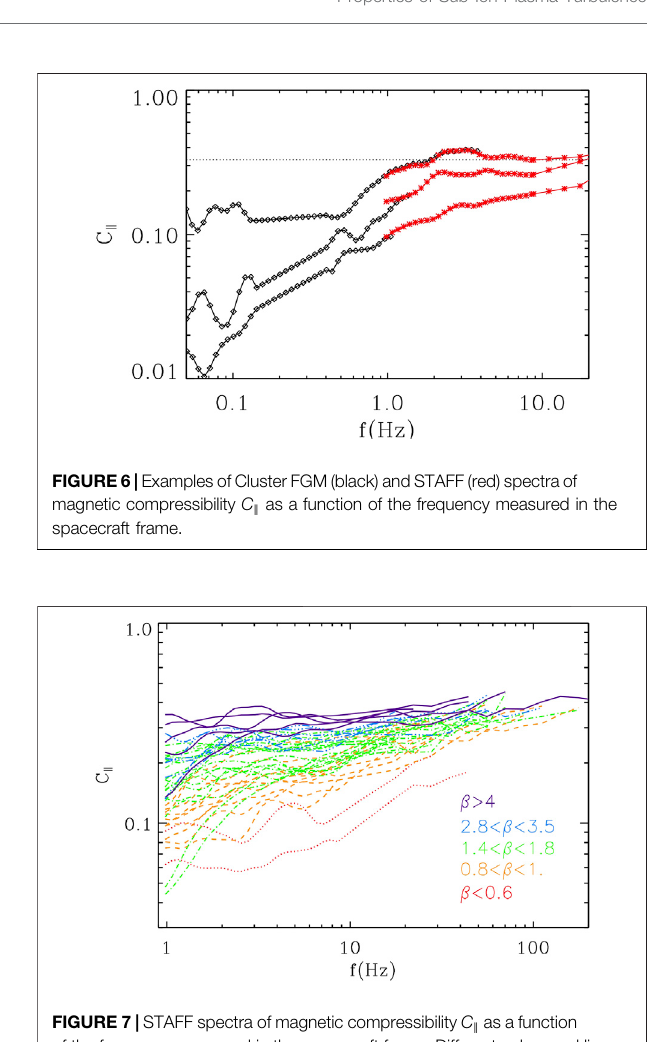
FIGURE 7 | STAFF spectra of magnetic compressibility C (cid:3) as a function of the frequency measured in the spacecraft frame. Different colors and lines identify different groups of intervals with given β